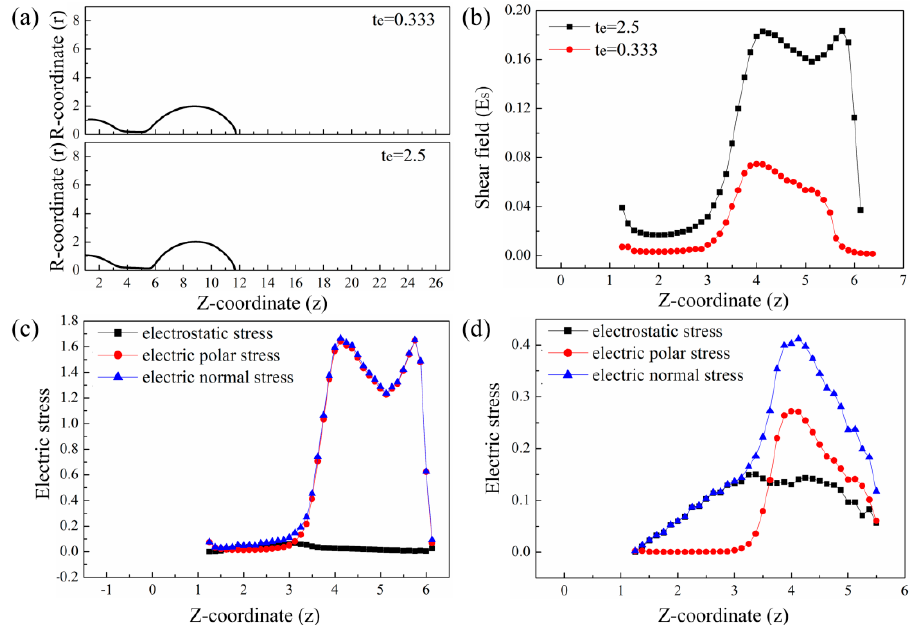
Figure 7. The comparisons of the electric stresses for liquids with different CRTs at the instant when t = 0. ( a ) The profiles of the drops of liquids with different CRTs. ( b ) The electric shear field along the surface of the drop for liquids with different CRTs. ( c ) The electric normal stress for liquid with CRT of t e = 2.5. ( d ) The electric normal stress for liquid with CRT of t e = 0.333. The other parameters of the liquids are ε r = 50, Oh = 0.05, φ = 6, Q s = 0.314 .